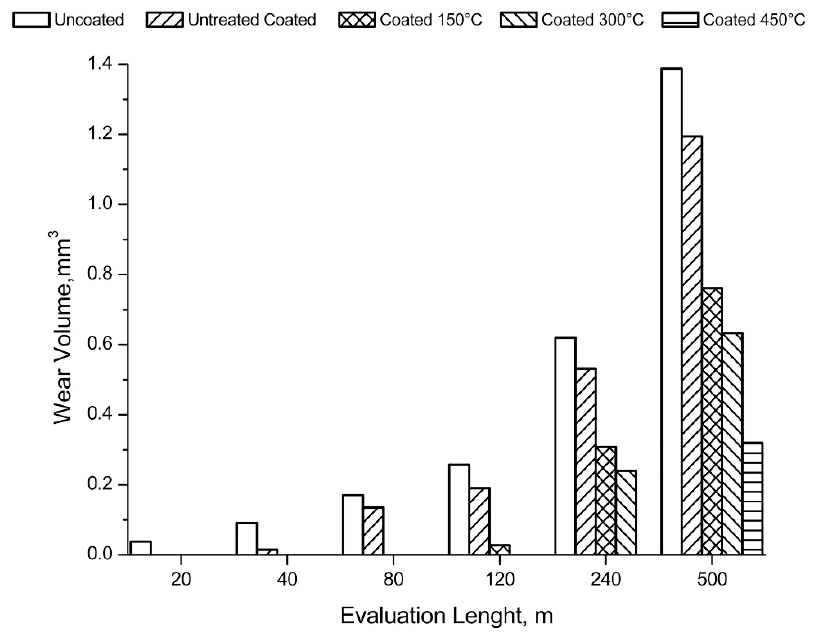
Figure 12. 3D maps of the linear reciprocating trails.